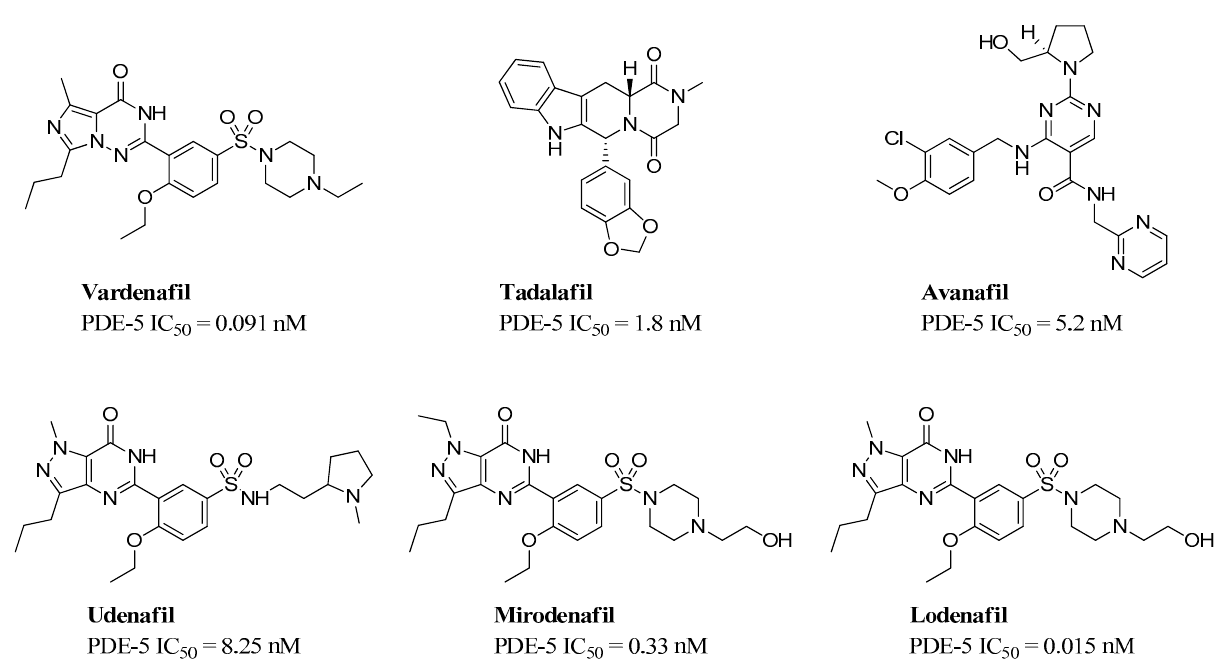
Figure 4. Chemical structures and IC 50 values of commercial PDE-5 inhibitor.